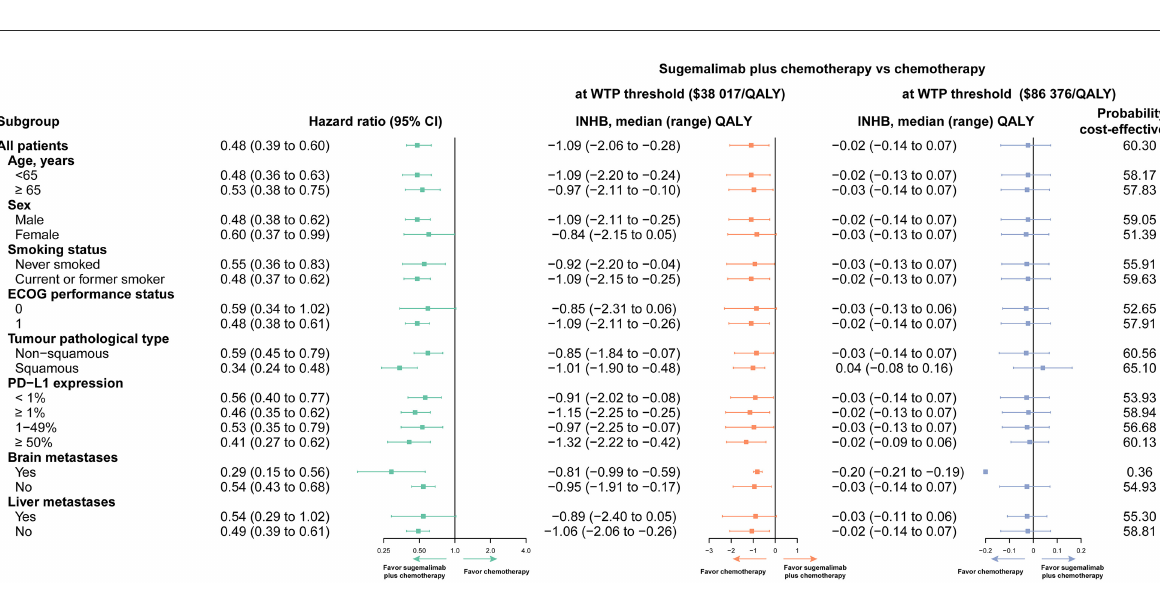
FIGURE2 Subgroup analyses obtained by varying the hazard ratios (HRs) for progression-free survival (PFS). INHB, incremental net health benefit; WTP, willingness to pay; QALY, quality-adjusted life-year; PD-L1, programmed cell death ligand